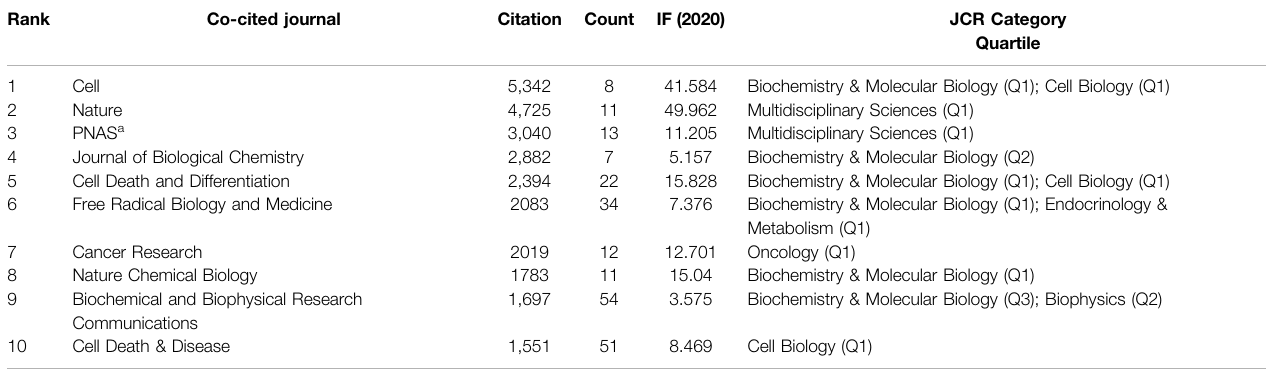
TABLE 6 | Top 10 co-cited journals by papers of ferroptosis research in